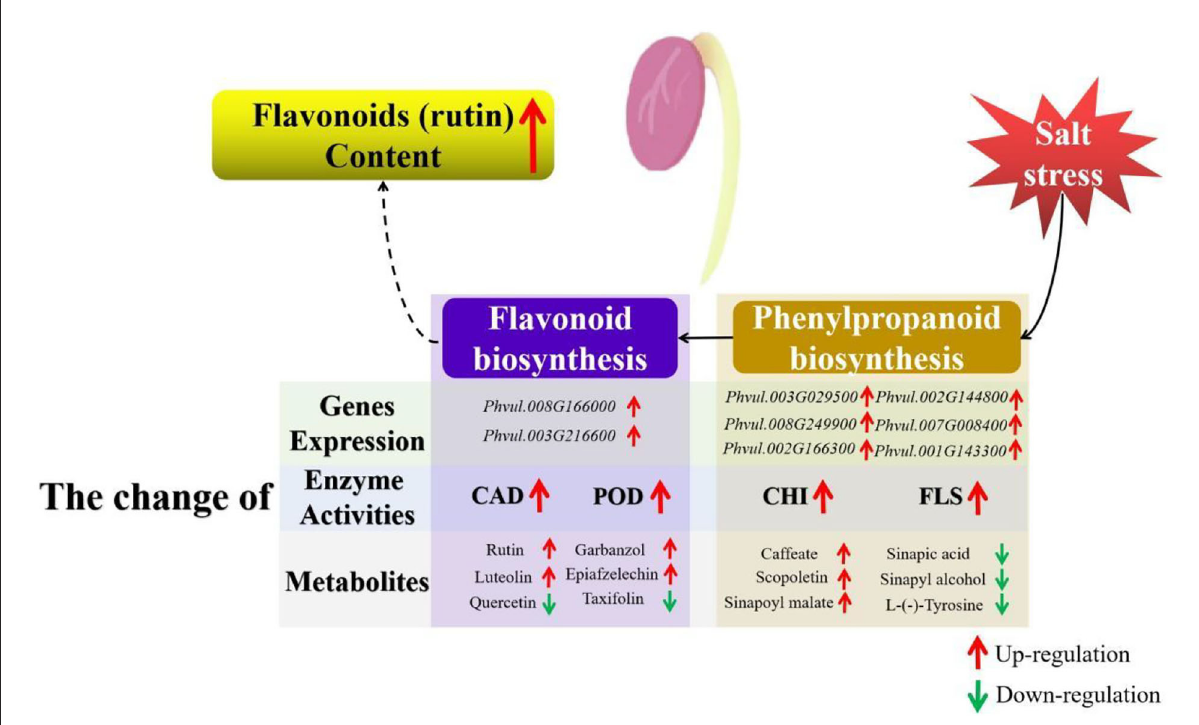
FIGURE8 Schematic illustration of the mechanism of the flavonoid accumulation in germinating common beans under salt stress. The brown box represents the phenylpropanoid biosynthesis pathway, while the purple box represents the flavonoid biosynthesis pathway. Red arrows represent upregulation, while green arrows represent